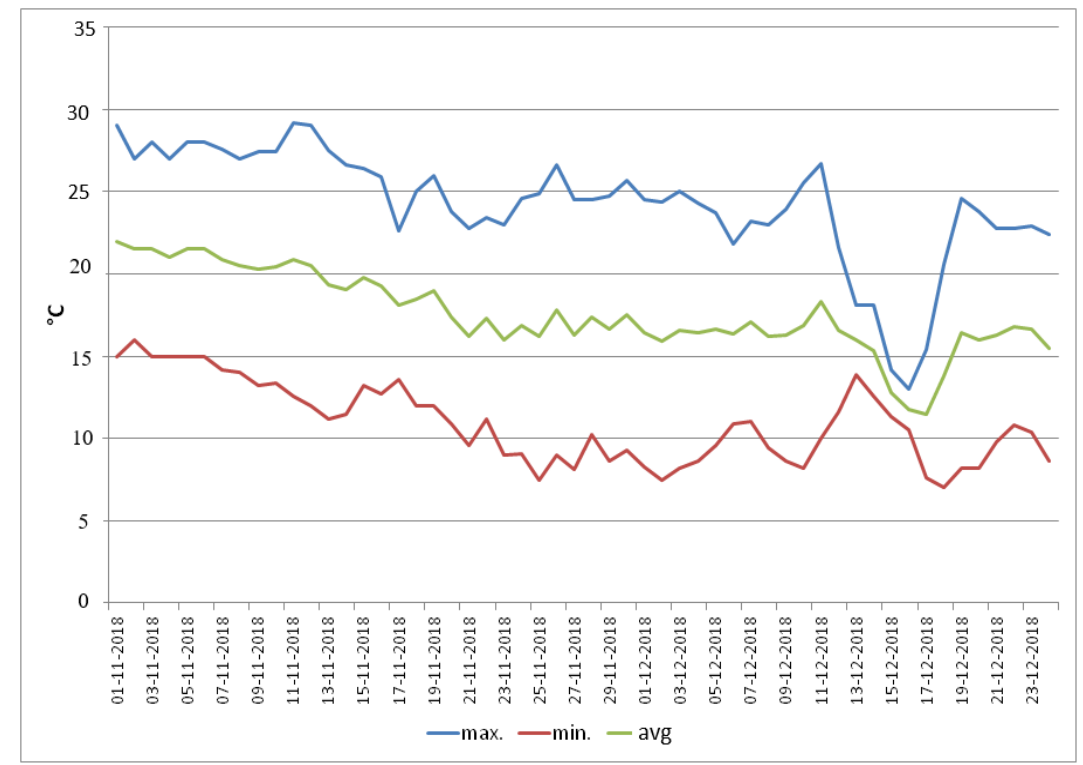
Figure 1. Weather data (maximum (max), minimum (min) and average (avg) temperature) from sowing up to 40 days, when the plants were moved to growth chamber.